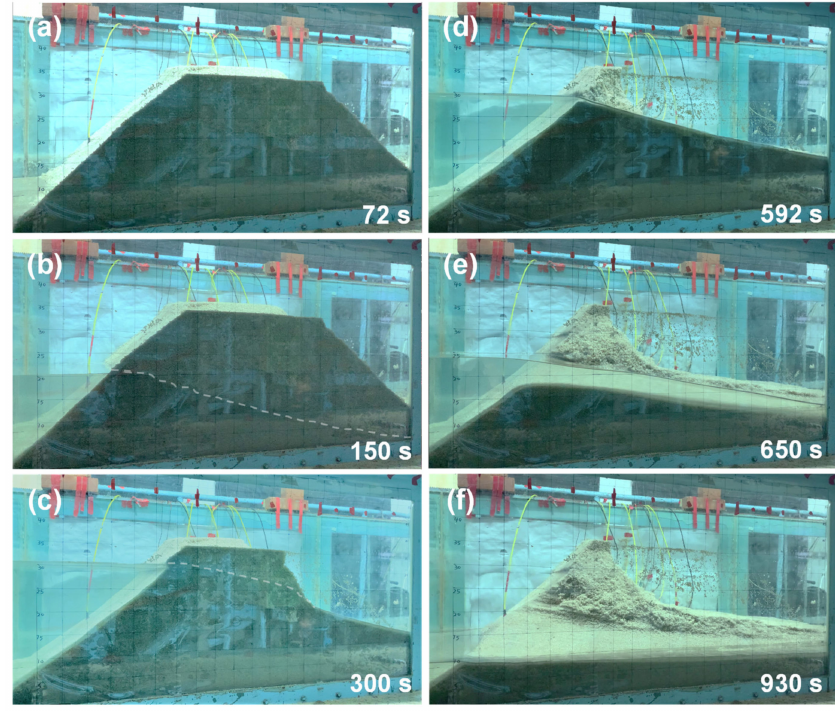
Figure 6. Side-view images at different test